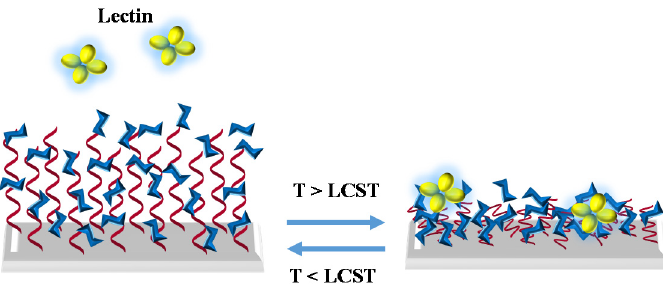
Figure 3. Representation of interaction between random thermoreversible glycopolymers attached to surface and